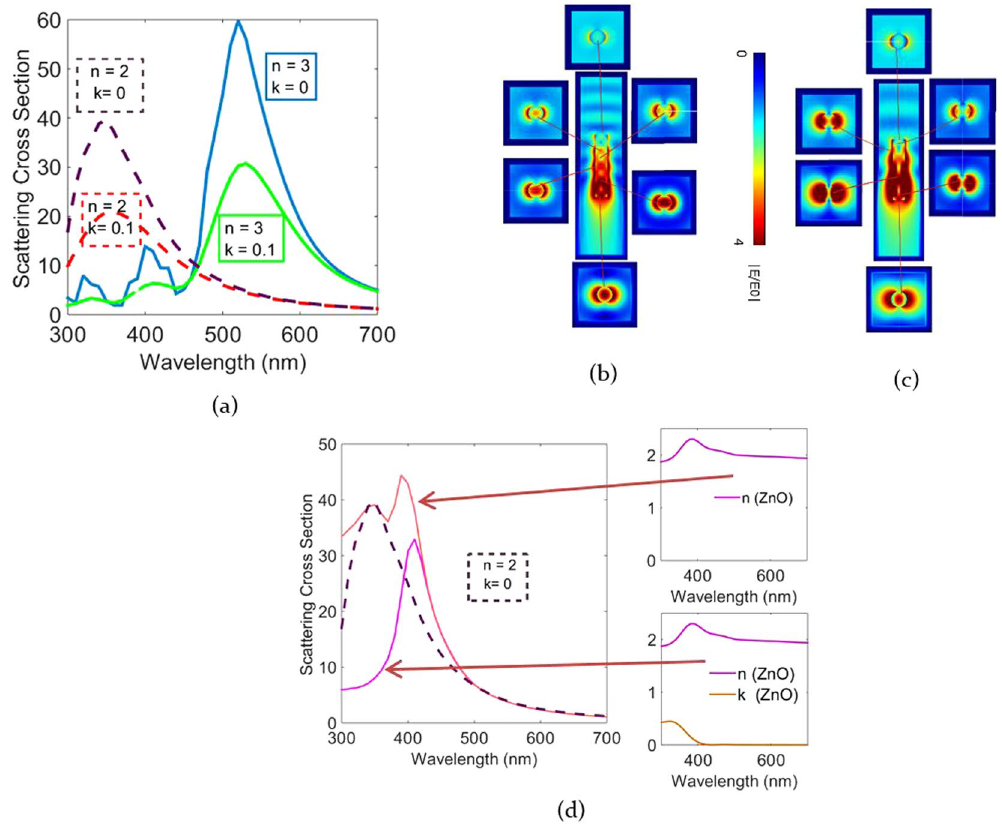
Figure 5. ( a ) Scattering cross section for rod refractive indices n + ik = (2 + 0i, 2 + 0.1i, 3 + 0i, 3 + 0.1i) ( b ) near field images of rod rod with index 2 + 0i at its resonant wavelength (350 nm) ( c ) near field images of a rod with index 3 + 0i at the resonant wavelength (530 nm) ( d ) scattering curves for ZnO with dispersive n-k data with and without